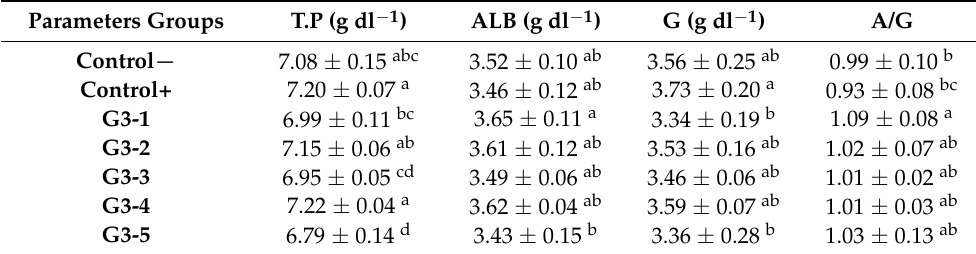
Table 7. Effect of wheat and barley grassed on changes in the total protein, albumin, and globulin of rats exposed to toxic metals (mean ± SD). Parameters